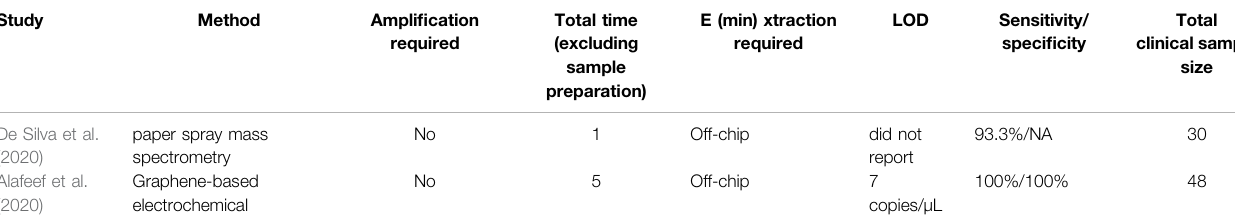
TABLE 4 | Other paper-based